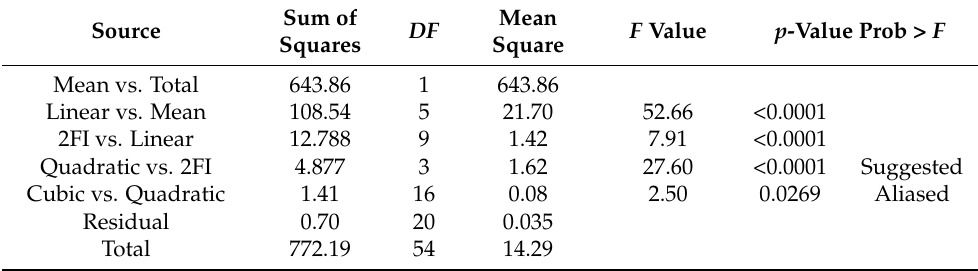
Table 4. Comparison of models.